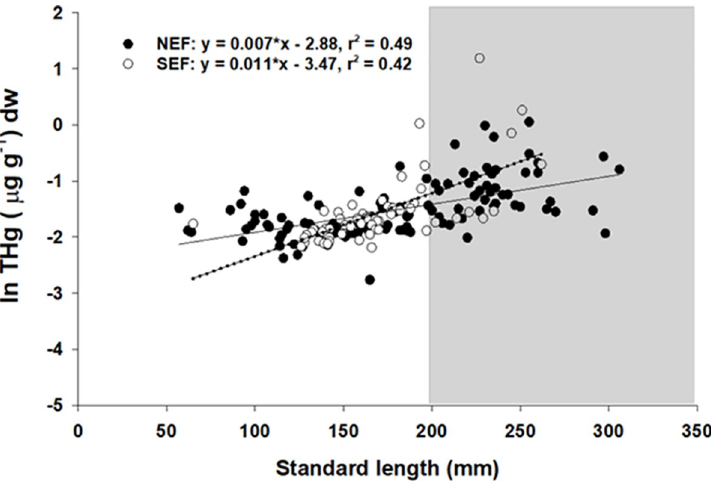
Fig 3. Relationships between lionfish and THg concentration by study location. Linear regression relationships between size (Standard length) and total mercury concentration in lionfish from NEF (solid circles, solid line) and SEF (open circles, dotted line). The shaded region indicates the sizes (SL > 196 SL) for which lionfish THg was significantly higher ( α = 0.05) in SEF than in NEF.